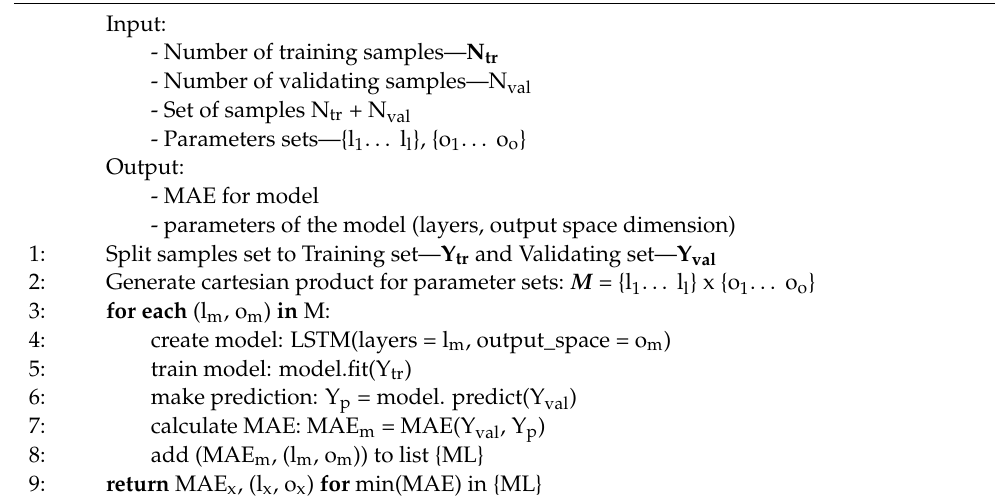
Algorithm 4: Grid search parameters of LSTM network.